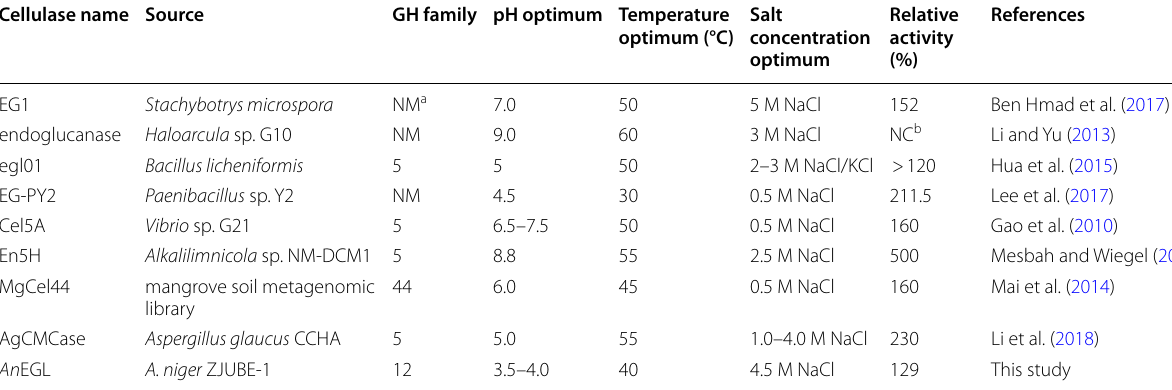
a Not mentioned b The relative activity cannot be calculated because there was no activity in the absence of NaCl